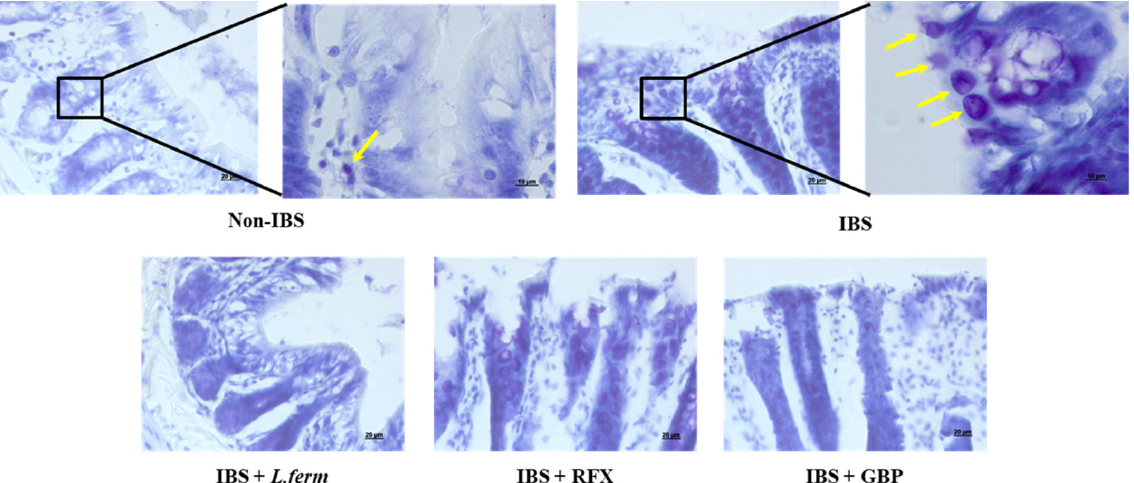
Figure 5. Mastocytosis in colonic tissue in DCA vehicle (Non-IBS), 4 mmol/L DCA (IBS)-, L. fermentum (10 9 CFU) ( L. ferm )-, Gabapentin at 70 mg/kg (GBP)- and Rifaximin at 150 mg/kg (RFX)- treated rats. Representative distal colon tissue stained with toluidine blue (scale bar = 20 µ m). Yellow arrows show mast cells inactivated in Non-IBS tissue and mast cells activated in IBS tissue at 100X.